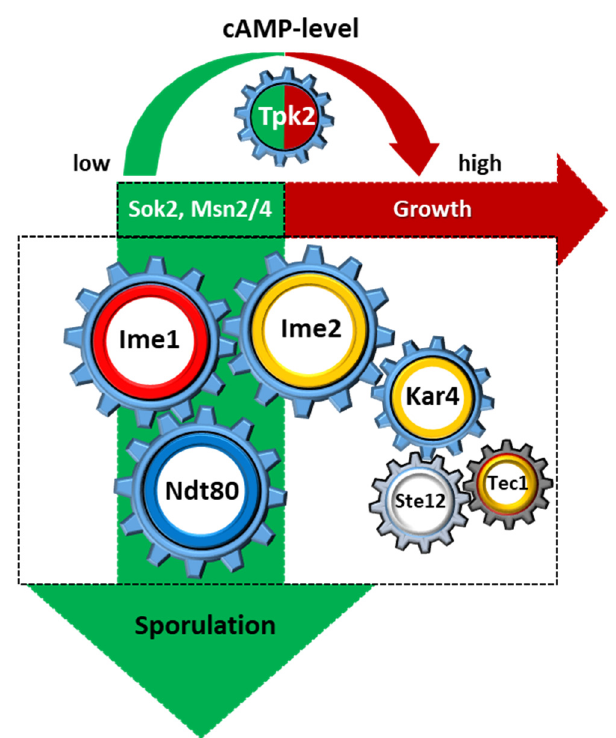
Figure 3. The Gear Box of Ashbya sporulation. Graphic description of the key regulatory components governing sporulation and the core set of 124 conserved sporulation specific genes. The cAMP/PKA pathway drives either vegetative growth or promotes sporulation depending on the nutrient status. High levels of alpha2 protein can lock cells in the vegetative state. For phenotypic description of mutant strains see Table 1.